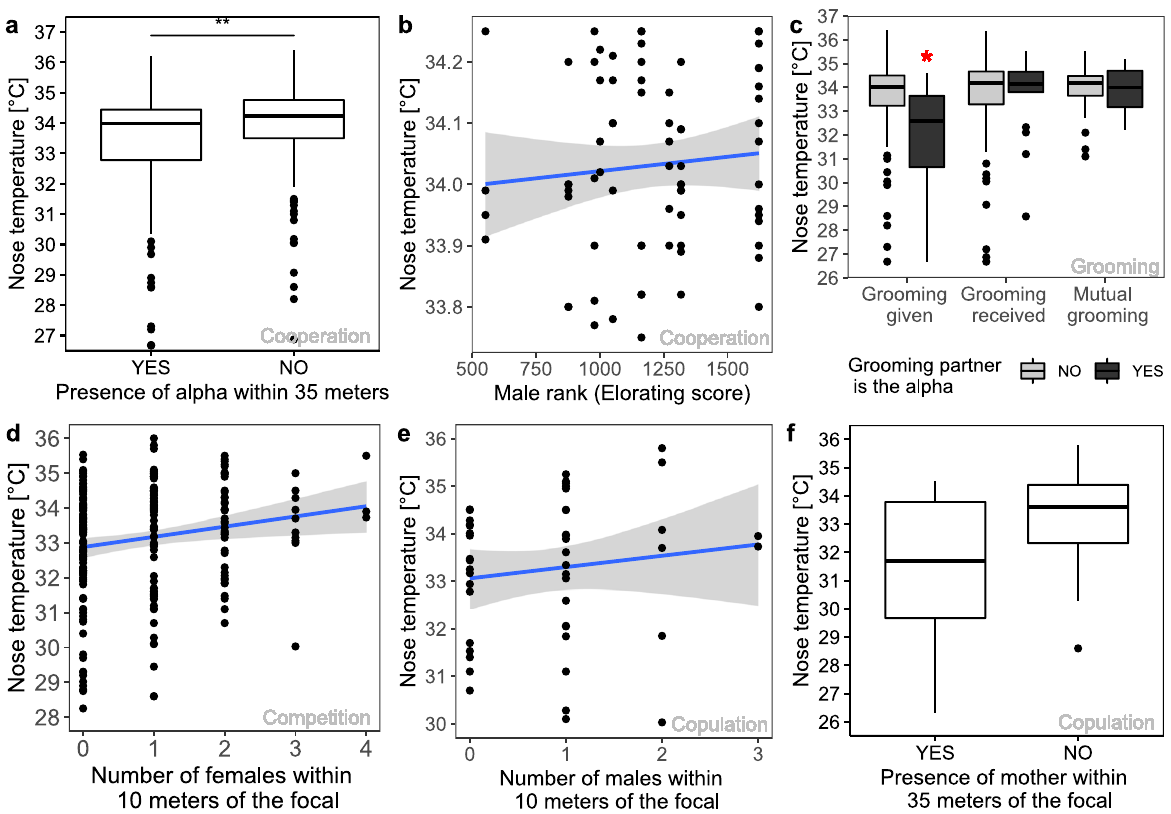
Figure 2. Thermal response to daily events considering social variables. Nose temperatures depending on ( a ). The presence or absence of the alpha male within 35 m during cooperative events (**p < 0.01) and ( b ) on the dominance rank of the focal individual during cooperative events (n = 339). ( c ) Nose temperatures depending on the type of grooming and if the grooming partner was the alpha male or not. The event when the focal individual is grooming the alpha without reciprocation is associated with lower nose temperatures compared to all other events (*p < 0.05) (n = 287). ( d ) Nose temperatures as a function of the number of females within 10 m during competitive events (n = 241). Nose temperatures depending on ( e ). The number of males within 10 m during copulation (n = 51) and ( f ) the presence of the focal individual’s mother within 35 m during copulation (n = 51). Whiskers show values within 1.5-fold of the interquartile range. Dots indicate individual values.